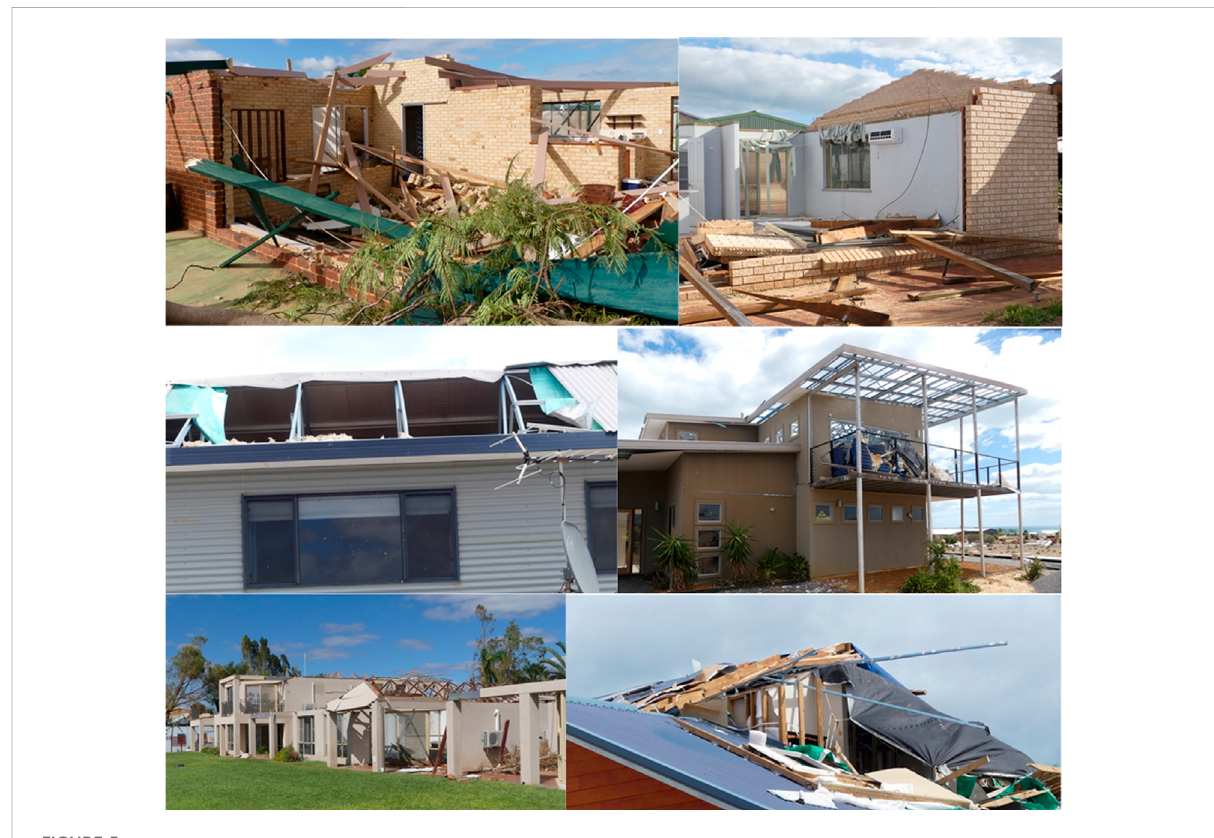
FIGURE 5 Roof damage because of high internal